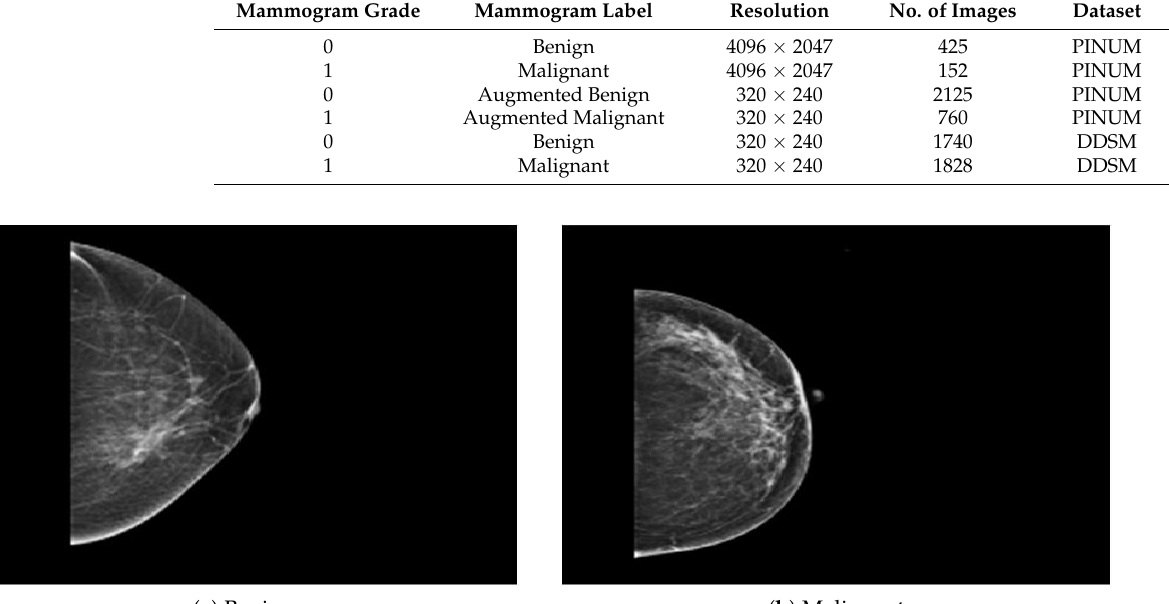
Figure 2. An example of breast mammogram images from the PINUM dataset. ( a ) The benign image. ( b ) The malignant image. The images were labeled by the expert radiologist in the dataset.